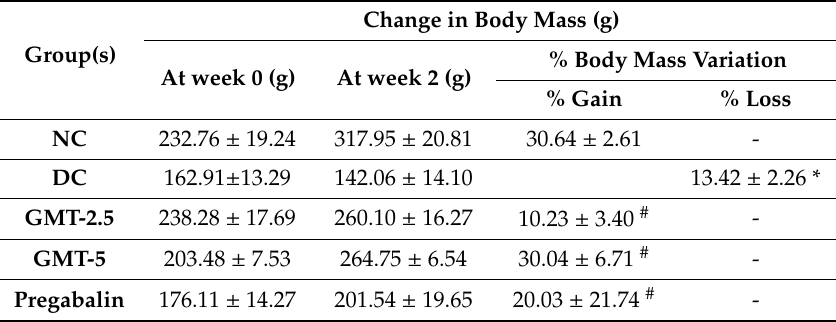
Table 1. E ff ect of chloroform extract of goat milk treated A. napellus on body mass.